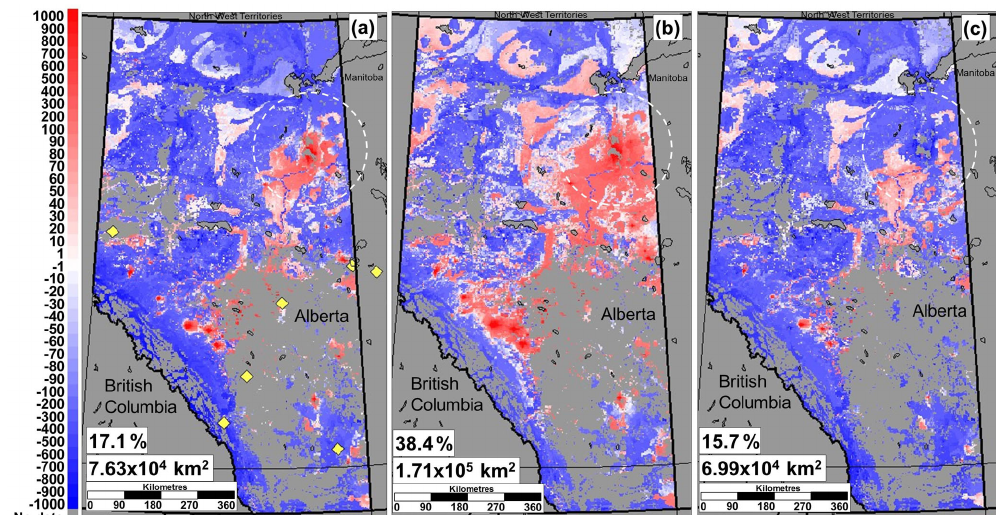
Figure 15. Predicted terrestrial ecosystem critical load exceedances with respect to sulfur and nitrogen (eqha − 1 yr − 1 ), Alberta Environment and Parks data. (a) GEM-MACH S and N deposition, 1994–1998 observed base cation deposition. Observation stations shown as yellow diamonds. (b) GEM-MACH S and N deposition, NPRI/Wang et al. (2015) base cation deposition. (c) GEM-MACH S and N deposition, base cation deposition scaled according to aircraft and precipitation-based corrections. Circled region: 140km radius diameter circle around the Athabasca oil sands.